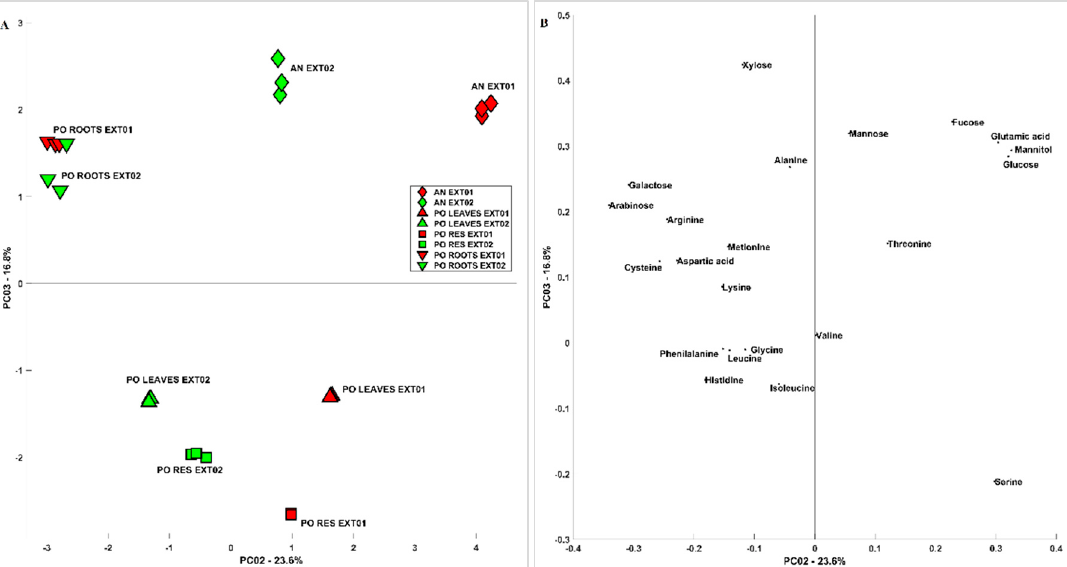
Figure 2. The PCA of the carbohydrate and aminoacidic content of Posidonia oceanica and Ascophyl- lum nodosum Extracts 1 and 2. ( A ) Scores and ( B ) loadings of PC2 vs. PC3.